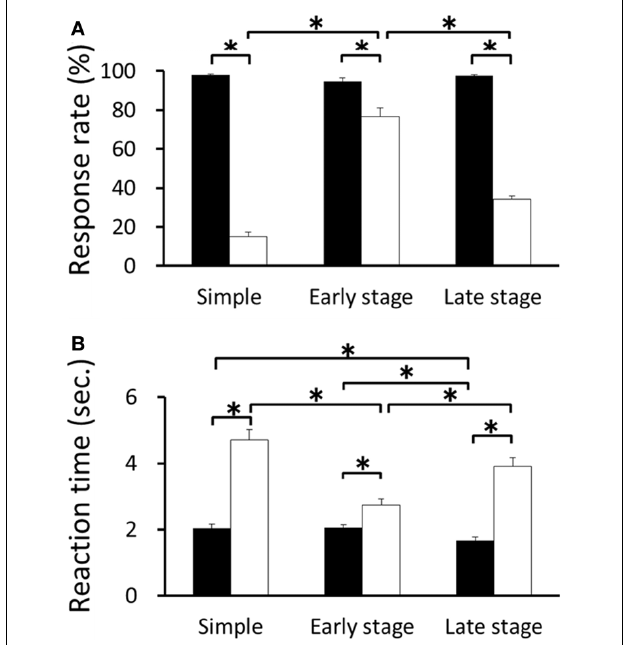
FIGURE 2 | The mean response rate (A) and reaction time (B) for RFT and non-RFT during recording sessions for the retention test for the simple discrimination task (Simple), early learning stage (Early stage), and late learning stage (Late stage) of the FN task ( ∗ p < 0 . 05 ). Error bars indicate s.e.m.